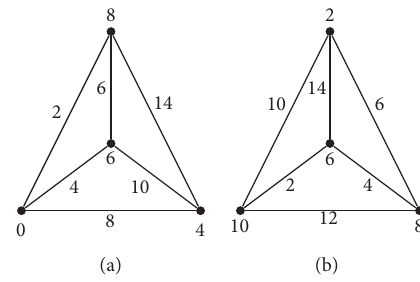
Figure 1: (a) A 2-edge even graceful labeling for K